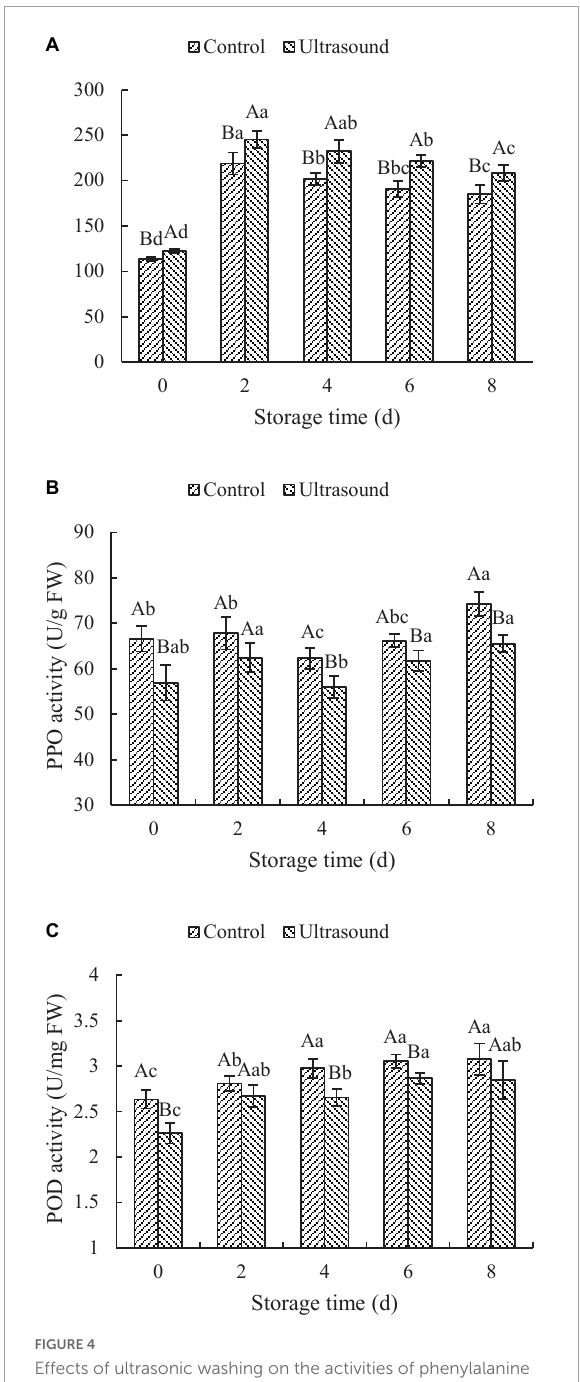
FIGURE4 Effects of ultrasonic washing on the activities of phenylalanine ammonia-lyase (PAL) (A) , polyphenol oxidase (PPO) (B) , and peroxidase (POD) (C) . The results represent the means of three triplicates ± standard deviations. Different capital letters mean that the effects of different treatments for the same day are significantly different ( P < 0.05); different lowercase letters mean that the effects of storage times for the same treatment are significantly different ( P < 0.05). Control: fresh-cut red cabbages were washed with sterile distilled water; ultrasound treatment: ultrasonic frequency mode of 28 ± 2 kHz, ultrasonic power density of 60 W/L, frequency cycle time of 400 ms, and ultrasonic time of 20